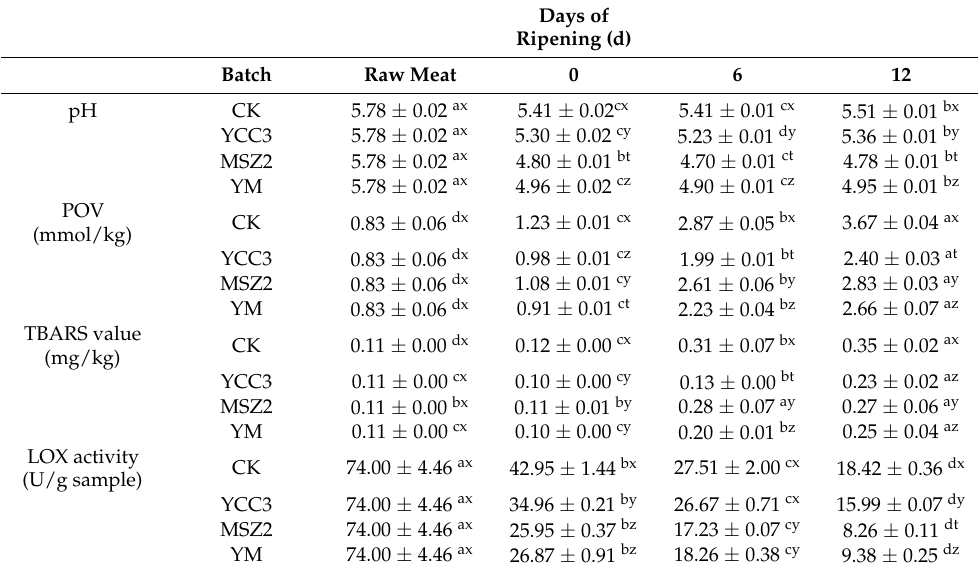
Table 2. pH, POV, TBARS value, and LOX activity in fermented sausage during ripening process.